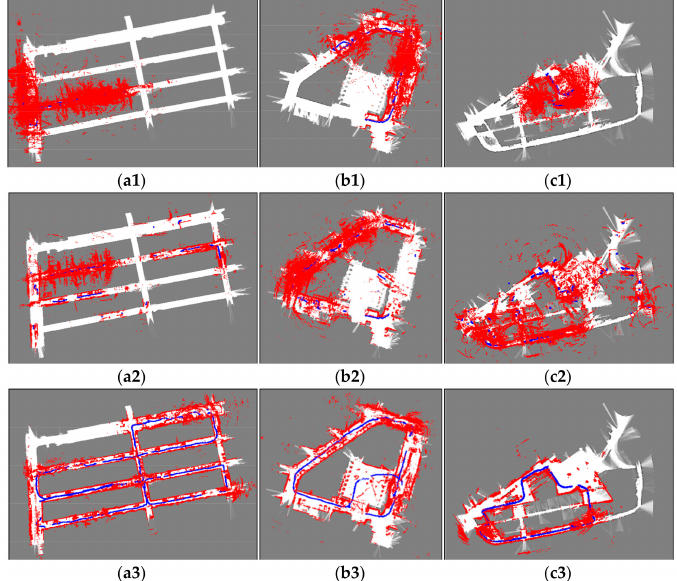
Figure 17. Localization results using real-world data. ( a1 – c1 ) show the localization result using AMCL. ( a2 – c2 ) show the localization result using augmented-MCL. ( a3 – c3 ) show the localization result using our method. Blue curves show the robot trajectories obtained by localization methods. Red point clouds represent the registered laser scan data using the trajectories. Based on the trajectories obtained by our method, laser scan data can be successfully registered in three ambiguous environments. The discontinuity of the trajectories obtained by our method is caused by the portal motion